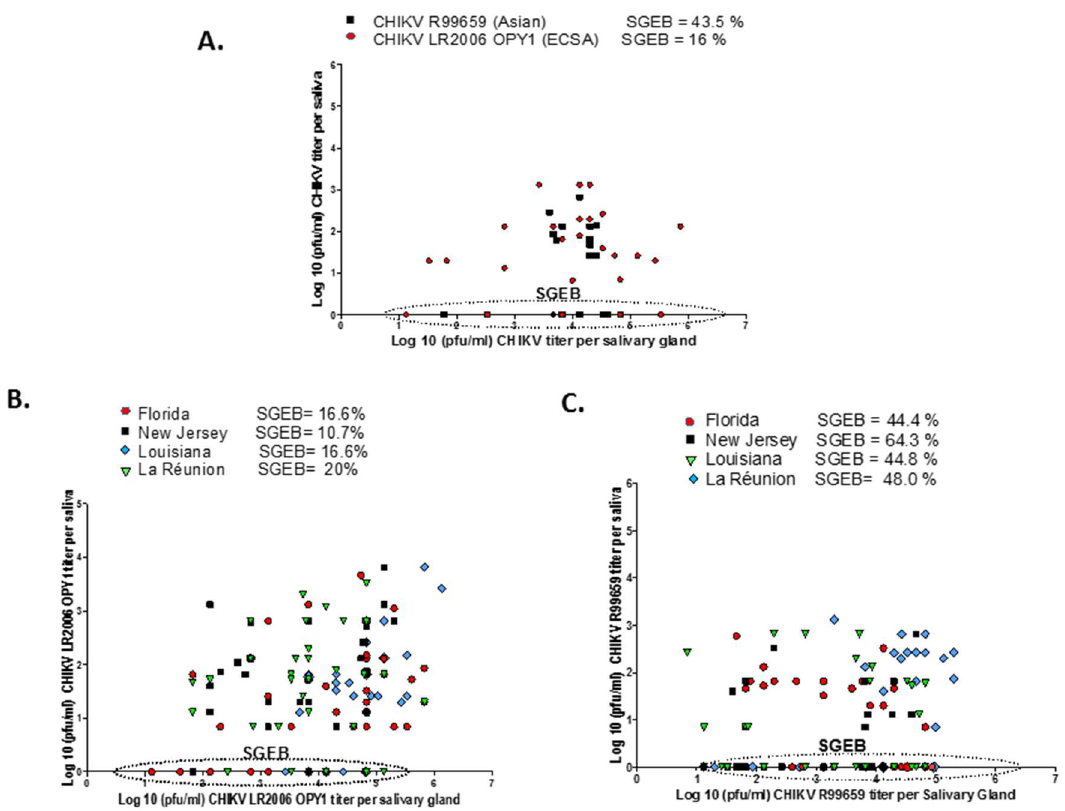
Figure 4. Correlation between CHIKV titers of saliva and salivary glands. The presence of a salivary gland escape barrier (SGEB) was tested by correlating CHIKV titers in salivary glands with virus titers in saliva. Saliva was collected at 9 days post infection and then salivary glands were dissected from the same mosquitoes. Virus titers from salivary glands and saliva were determined by plaque assays. ( A ) Correlation between saliva and salivary gland of Ae. aegypti (Poza Rica) infected with CHIKV R99659 ( • ) and CHIKV LR2006 OPY1 ( (cid:4) ). ( B ) Correlation between saliva and salivary